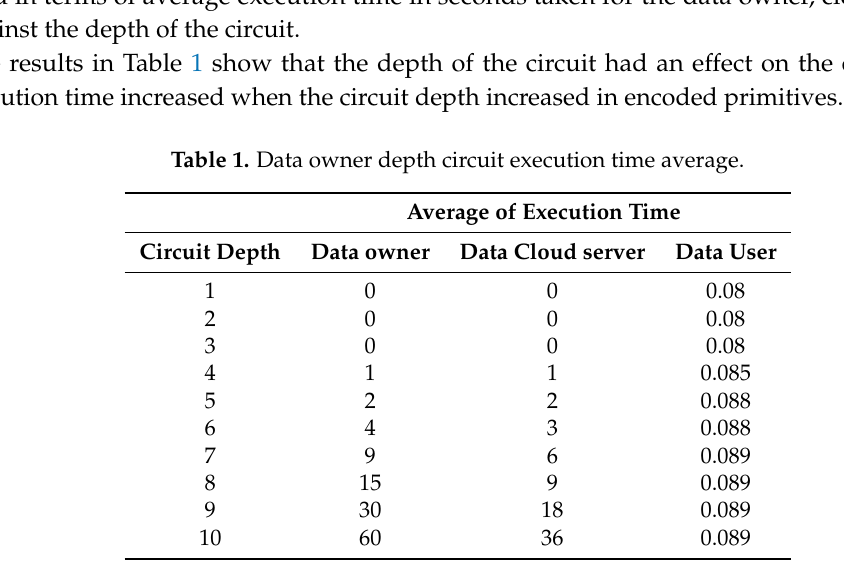
Figure 8. Download and decryption image.